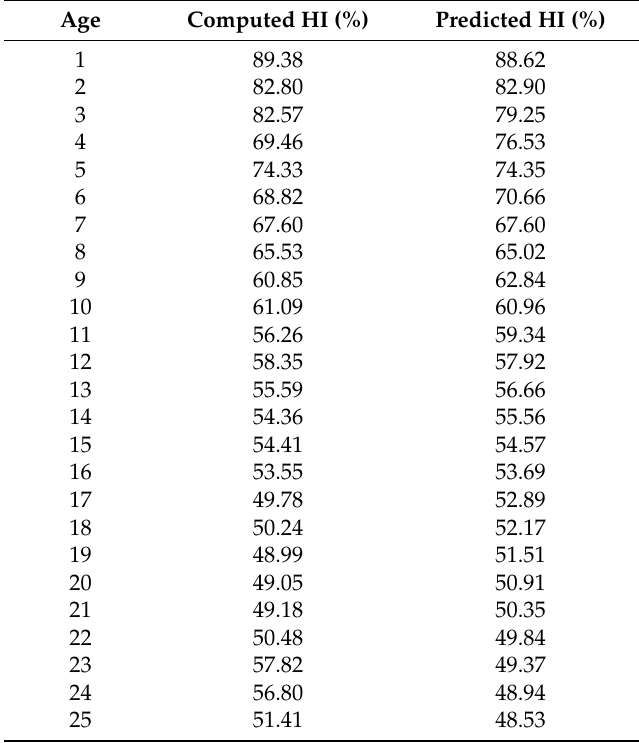
Table 4. Computed and predicted